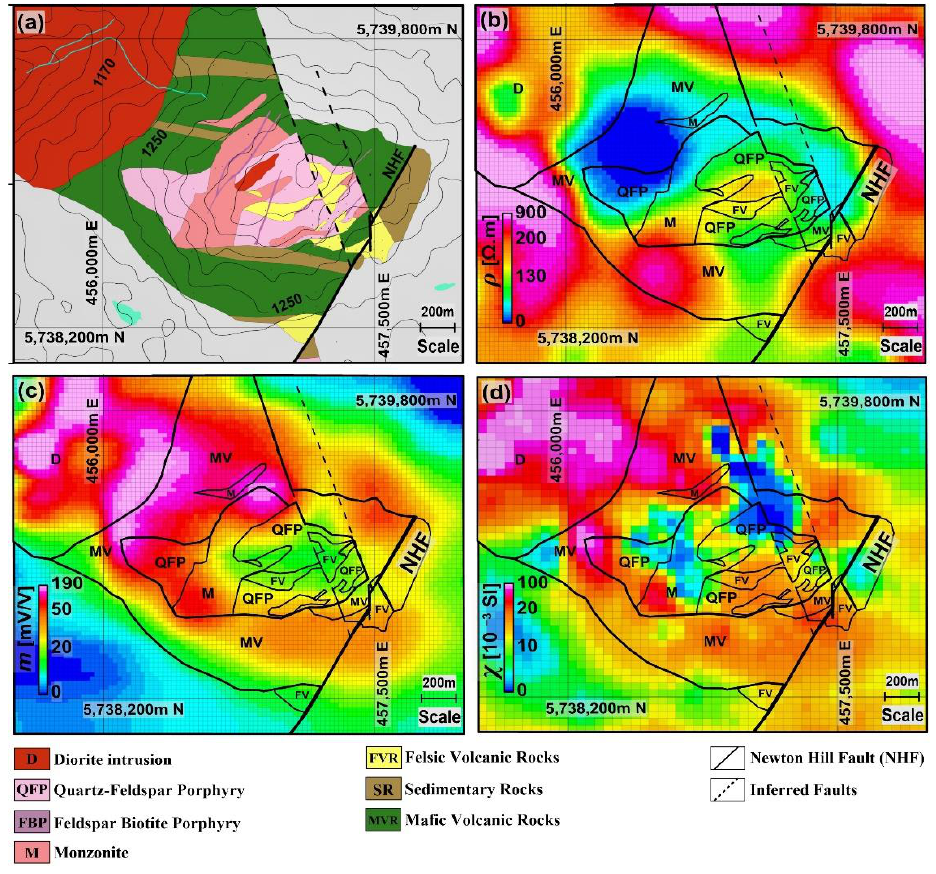
Figure 2. Geological and geophysical settings of the deposit: ( a ) Bedrock geology map at the deposit scale (sliced at an elevation of 1000 m). The light gray parts are undefined regions due to the lack of borehole information in the periphery of the deposit. Contours indicate topography. ( b ) Electrical resistivity model. ( c ) IP chargeability model. ( d ) Magnetic susceptibility model. The bedrock geology is overlaid on all geophysical models [27] .